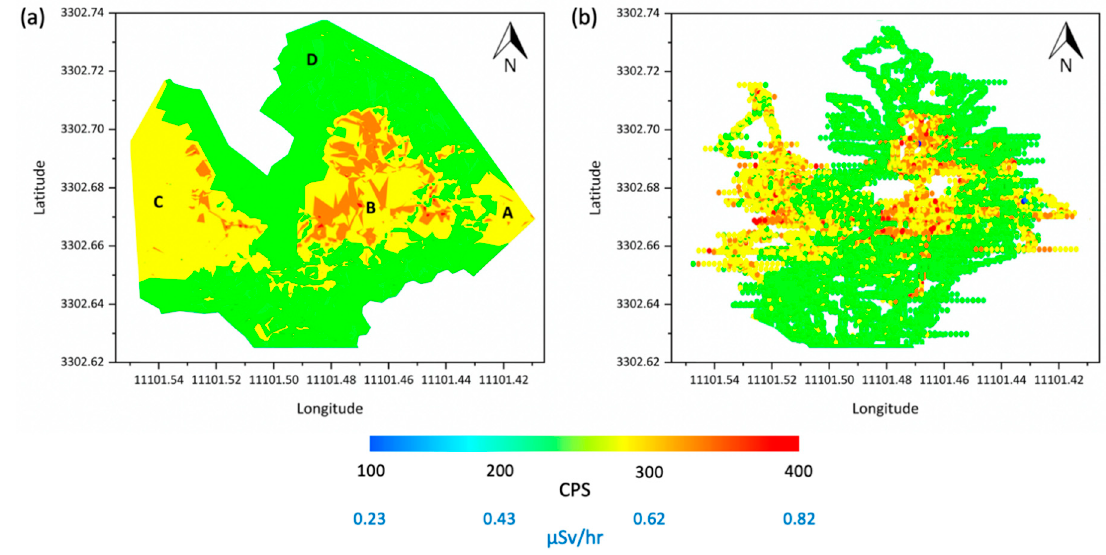
Figure 2. ( a ) Radiation intensity (total counts) contour plot, and ( b ) un-contoured radiation intensity plot for the Wooley Mine site, derived using the unmanned aerial vehicles (UAV) at a survey height of 35 m above site minimum.